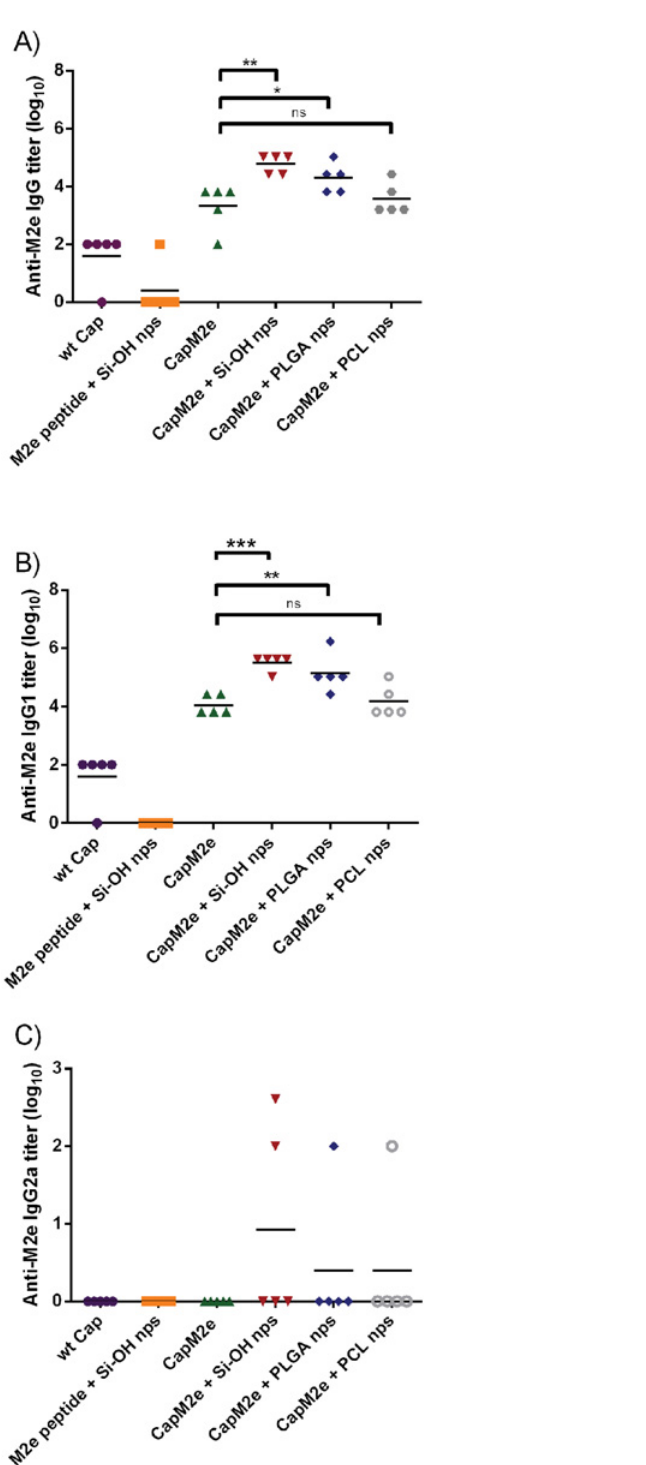
Fig 3. M2e-specific antibody titers in BALB/c mice following three subcutaneous immunizations with different formulations. A) Total IgG, B) IgG1, and C) IgG2a. * , p < 0.05; ** , p < 0.01; *** , p < 0.001; ns = not